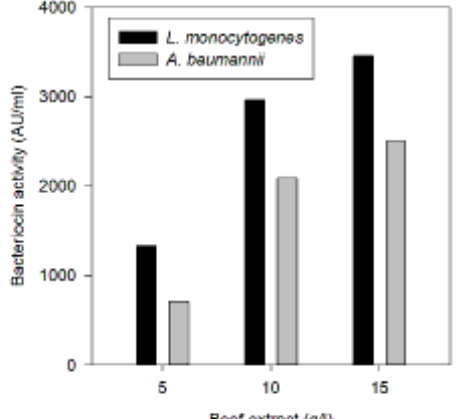
Fig. 6. Effect of beef extract on bacteriocin production